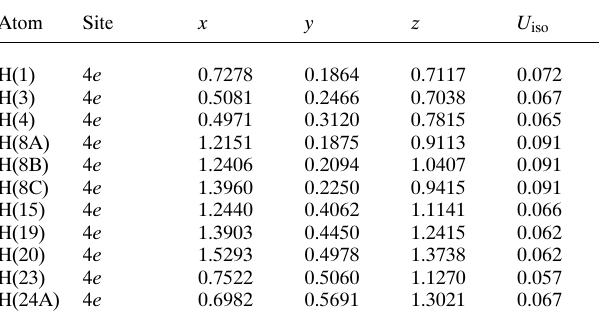
Table 2. Atomic coordinates and displacement parameters (in Å 2 )